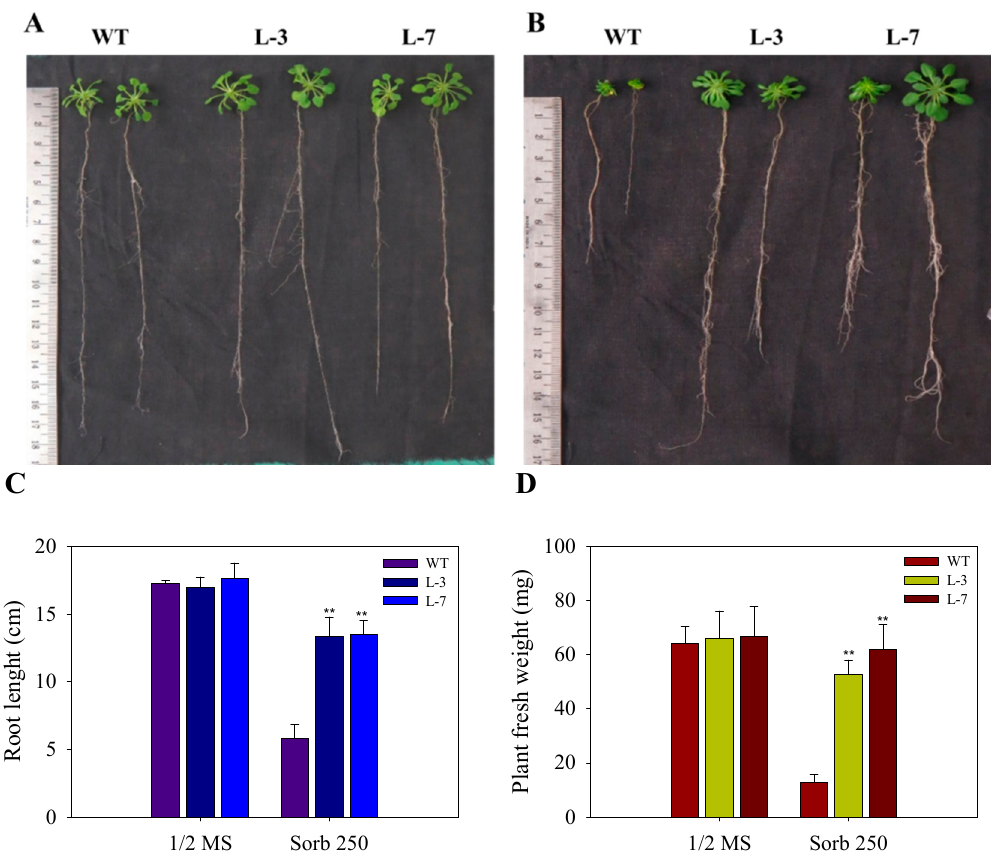
Figure 6. Effect of osmotic stress on the growth of WT and transgenic Arabidopsis plants ( A , B ) growth of plant under control (half strength MS) and osmotic stress (sorbitol 250 mM) conditions, respectively. Three replicates were used per treatment and the experiment was repeated thrice. ( C ) Root length of WT and transgenic L-3 and L-7 under normal and osmotic stress conditions; ( D ) Fresh weight of plants. In each case observation was made on day 44 after germination. For root length data, the average values of 15 plants of WT and transgenic lines were taken for each biological replicate (n). Data represent means of n = 3 ± SE. Two asterisks indicate that the mean values of transgenic lines were significantly higher than that of WT (control) when analyzed by one-way ANOVA ( p < 0.01).